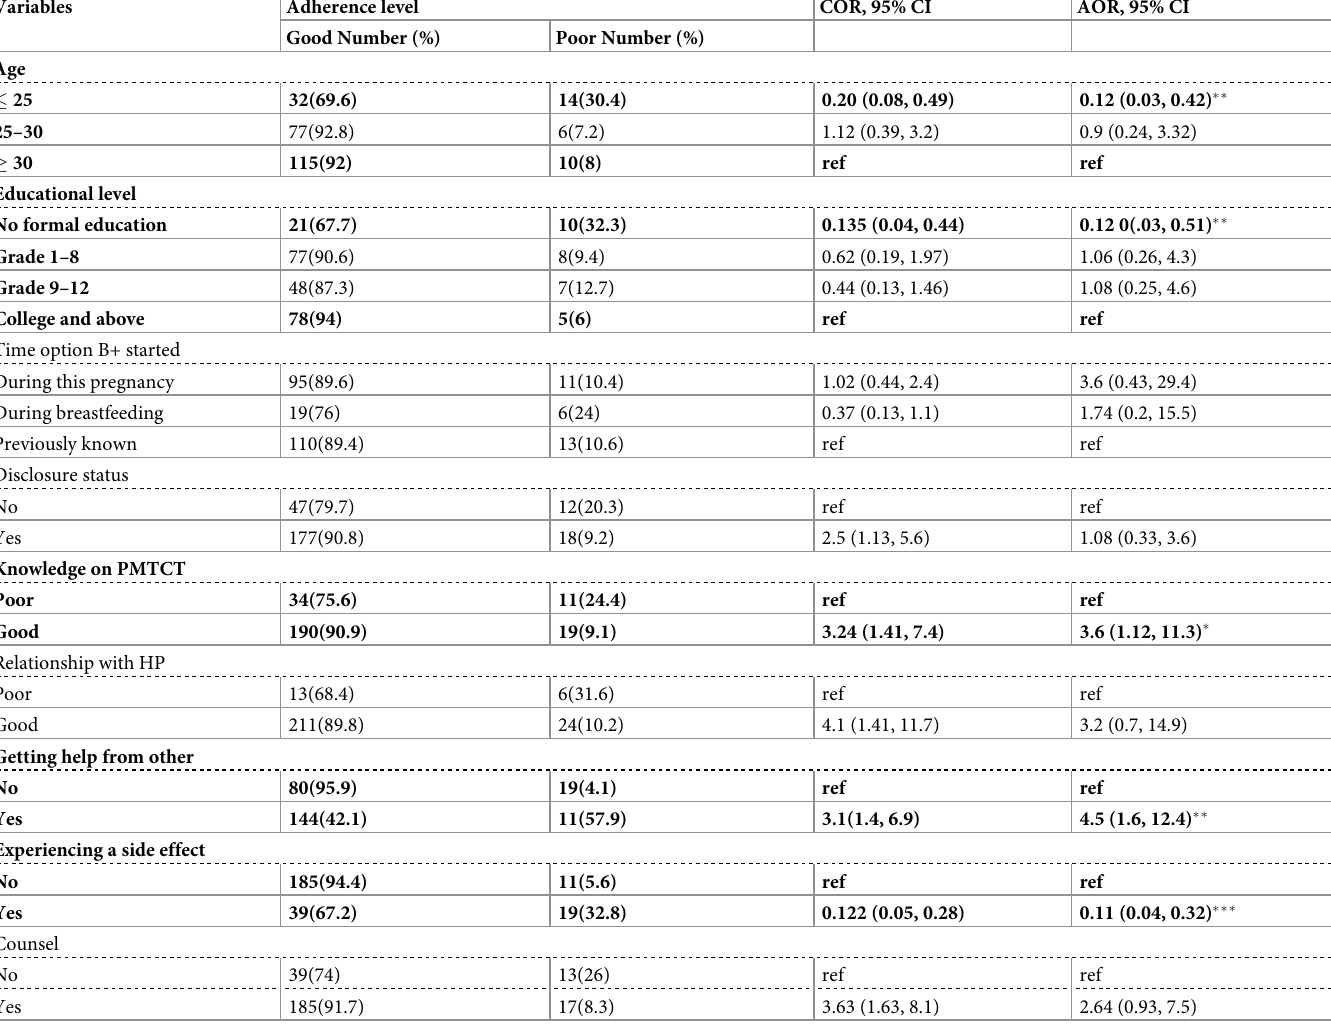
Table 4. Bivariate and multivariate analysis result of factors associated with adherence level of option B + PMTCT among pregnant & lactating mothers in selected governmental health facilities of Hawassa city, Southern Ethiopia, 2019/20